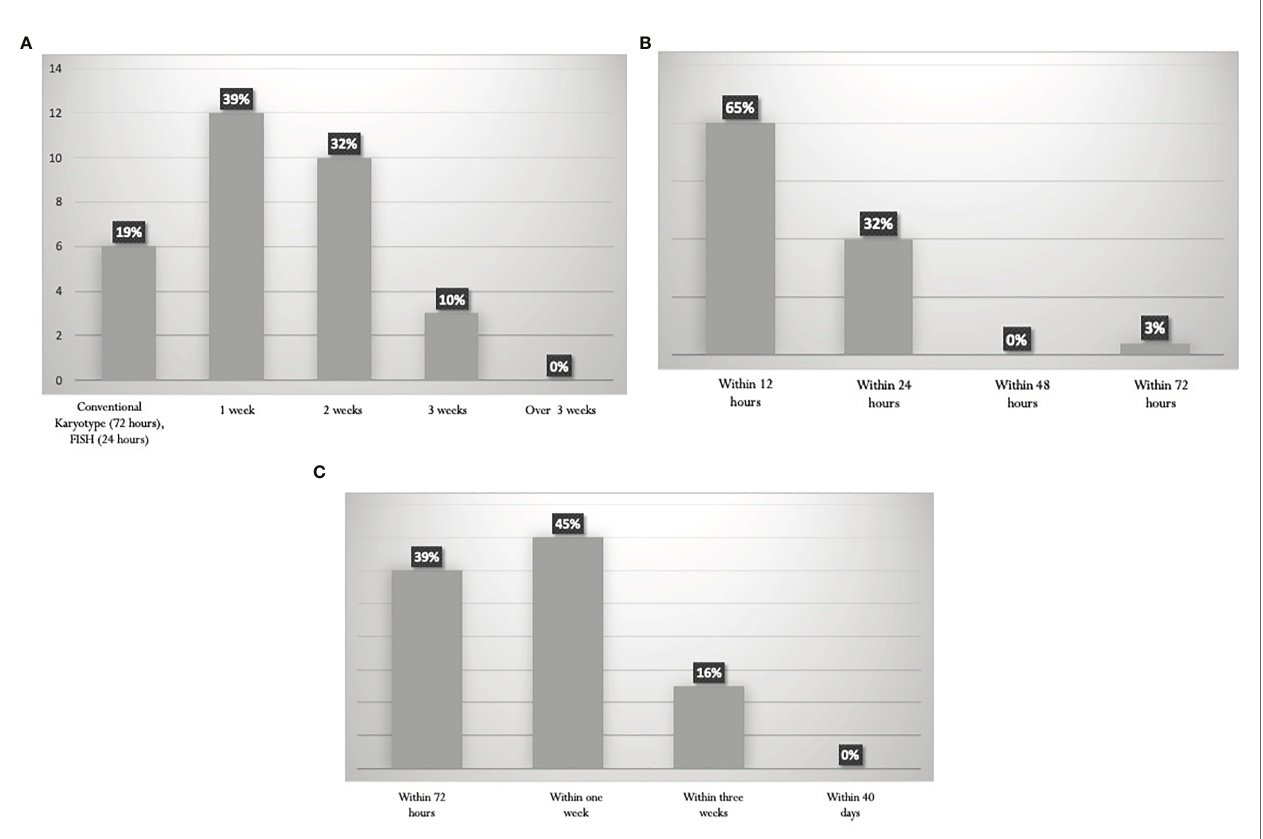
FIGURE 2 | Turnaround times for the diagnostics procedures. (A) Karyotype. (B) PML-RARalpha rearrangement by RT-PCR. (C) Other Recurrent genetic abnormalities (BCR-ABL1, FLT3, NPM1, RUNX1-RUNX1T1,